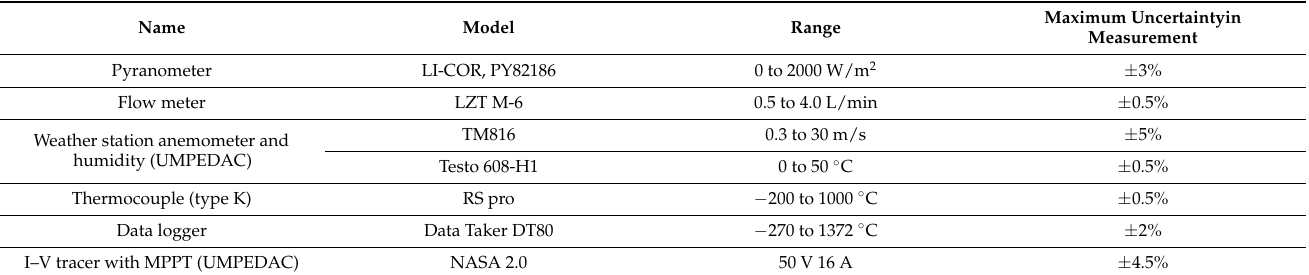
Table 4. The instruments’ measuring ranges and their associated